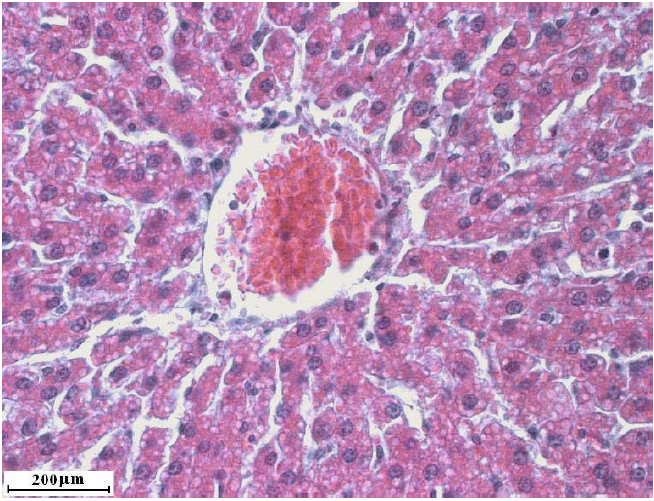
Figure 4. Liver cross section of rats treated with Coprinus comatus aqueous suspension for 7 days before one dose of carbon